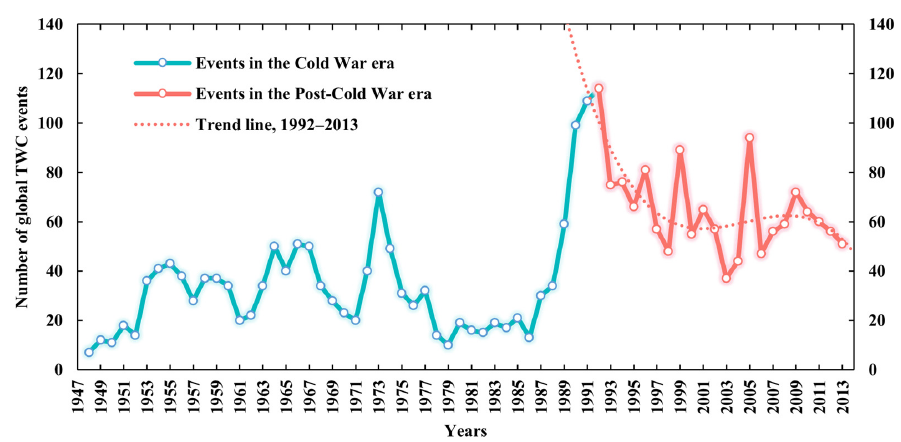
Figure 3. Annual variations of the number of global TWC events.